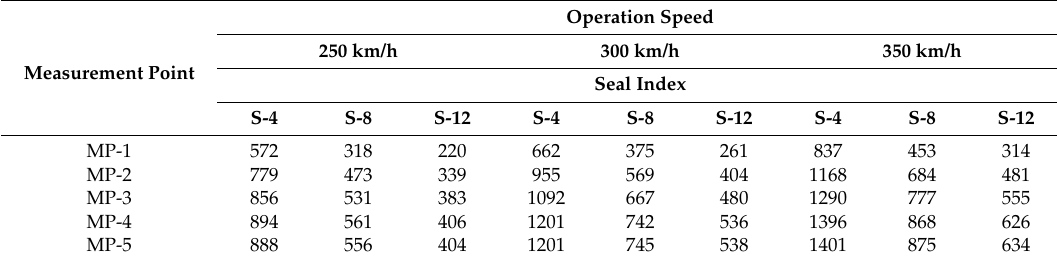
Table 4. The pressure differences in different cabins (Unit: Pa).